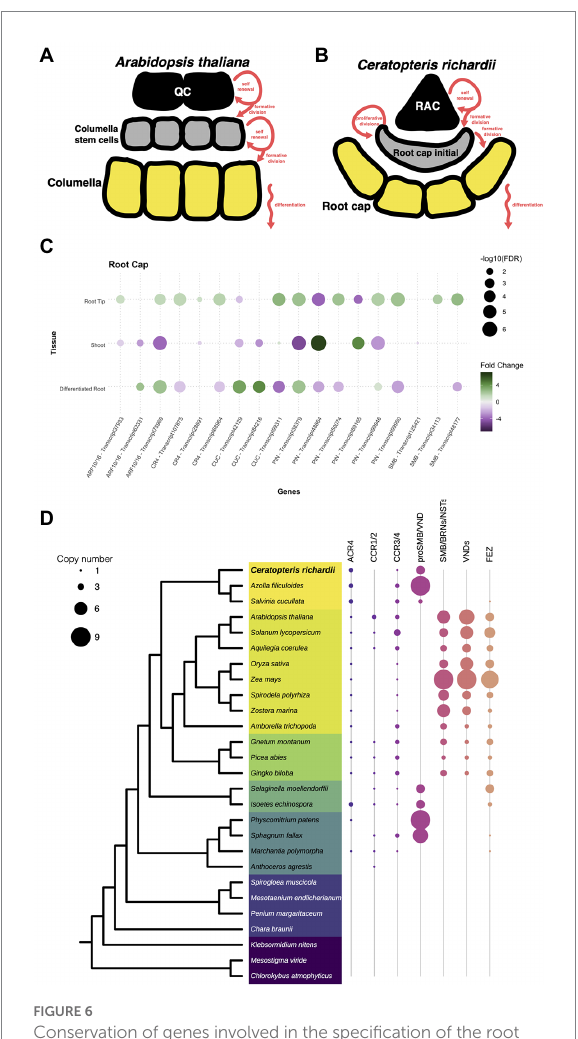
FIGURE 6 Conservation of genes involved in the specification of the root cap. (A,B) Schematic representation of the development of root cap between Arabidopsis and Ceratopteris. (C) Expression of Ceratopteris ortholog genes implicated in the root cap development and maturation in the segments tissues. (D) Schematic representation of the presence and absence of orthologs for ACR4, SMB, and FEZ throughout plant